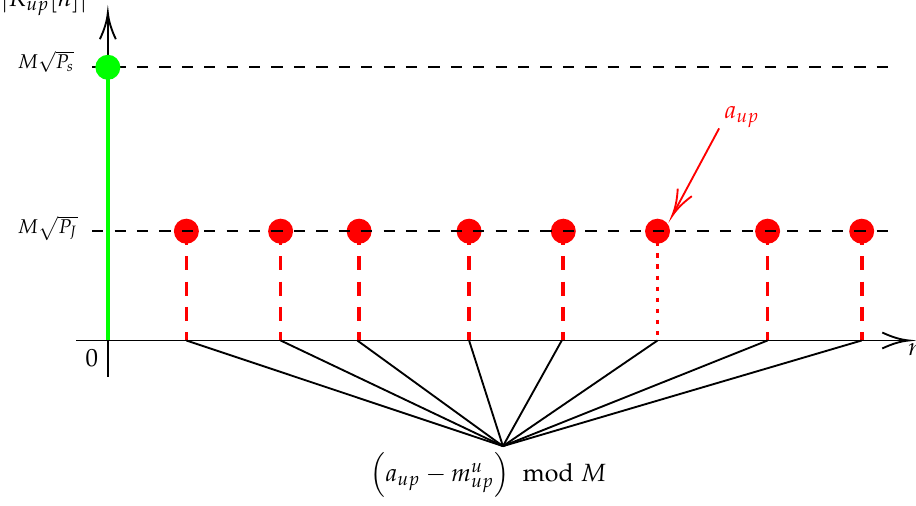
Figure 4. The modified preamble upchirp